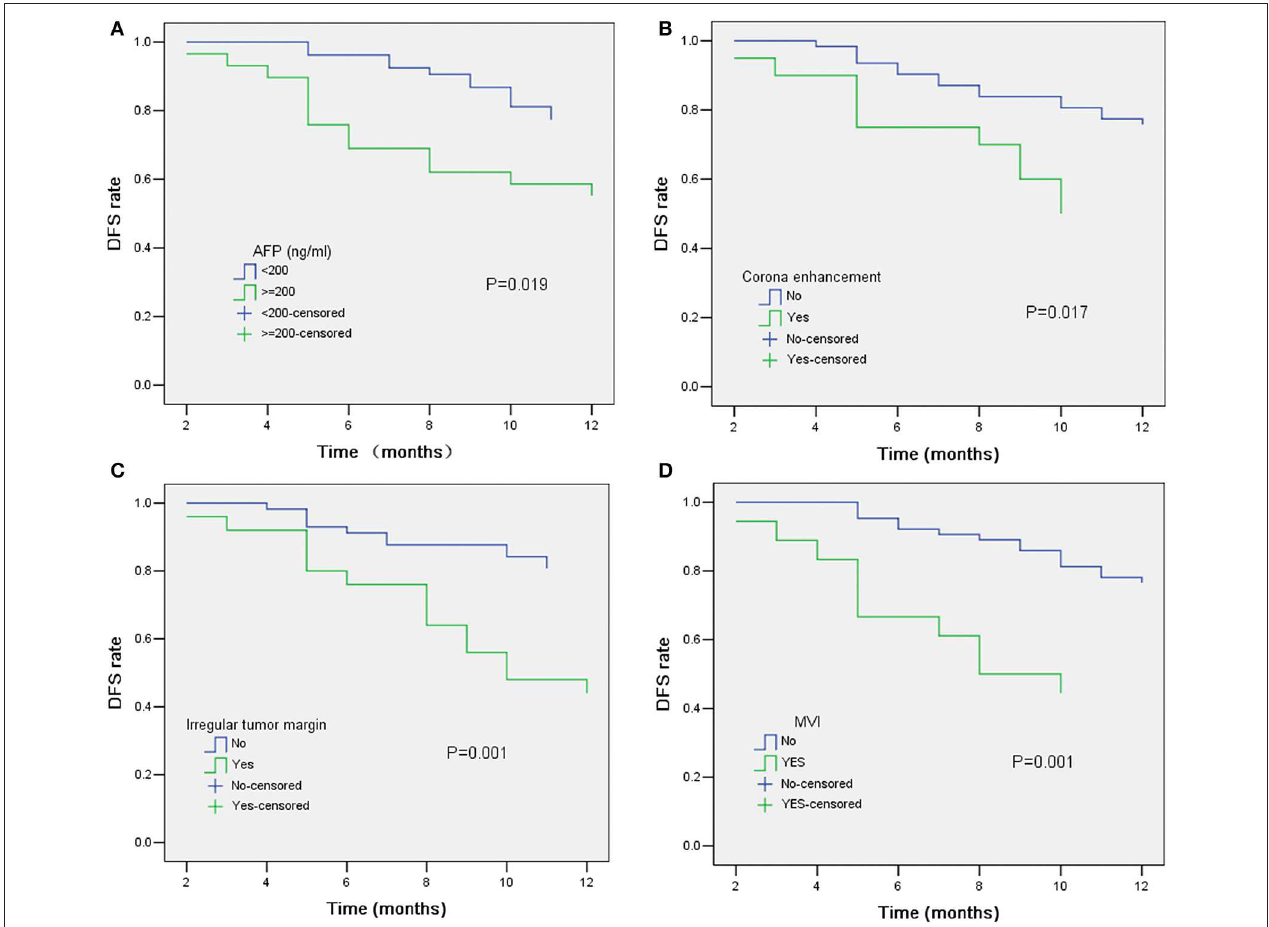
FIGURE 2 | Kaplan–Meier curves for RFS showing significant difference is seen between patients classified as: (A) AFP ≤ 200ng/ml and AFP > 200ng/ml (log-rank test, p = 0.019); (B) corona enhancement ( + ) and corona enhancement (–) (log-rank test, p = 0.017); (C) irregular tumor margin ( + ) and irregular tumor margin (–) (log-rank test, p = 0.001); (D) MVI ( + ) and MVI (–) (log-rank test, p = 0.001).